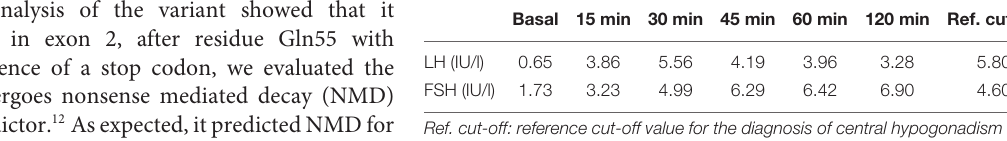
Frontiers in Pediatrics |